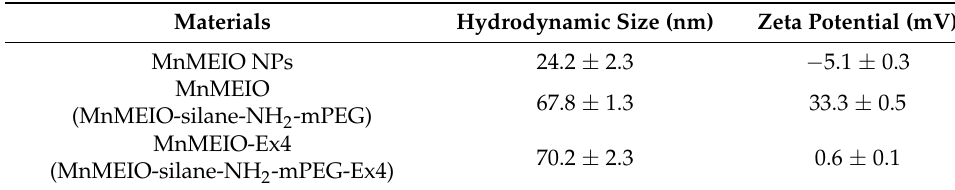
Table 1. Zeta potential and hydrodynamic size of